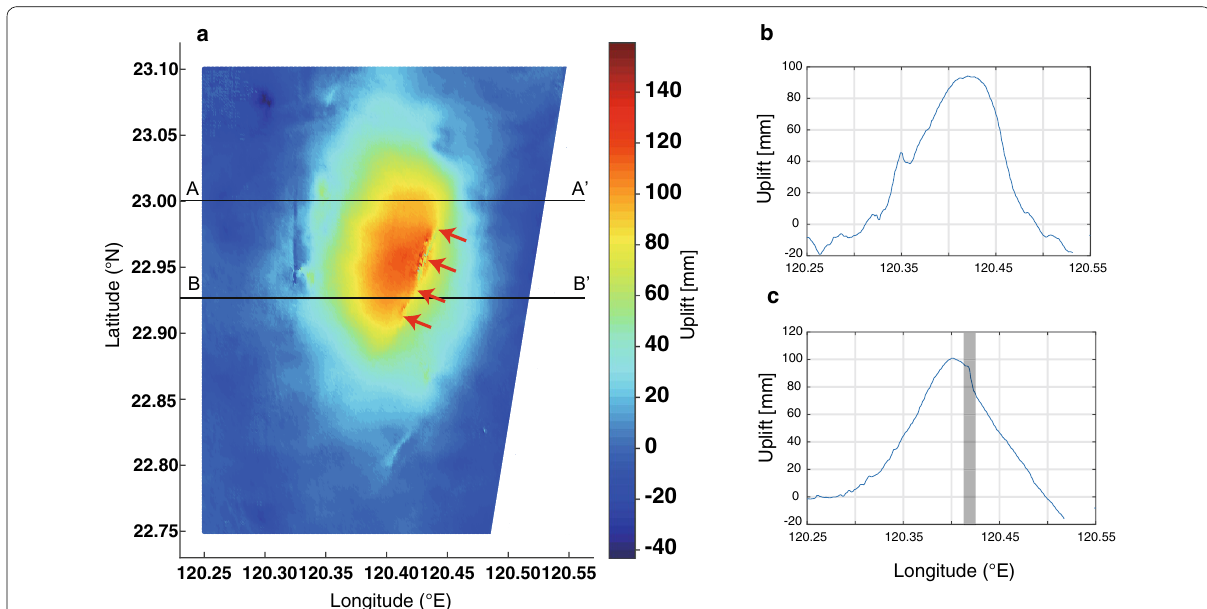
Fig. 4 Coseismic uplift due to the Meinong earthquake measured by ALOS-2. a Distribution of coseismic uplift. Gap in the amount of uplift is marked by red arrows. b Amount of uplift along the profile A–A ′ . c Amount of uplift along the profile B–B ′ . Gap in the amount of uplift can be seen and is marked by the shading as well as Fig. 3c. Note that both of the profiles A–A ′ and B–B ′ are the same as those in Fig.